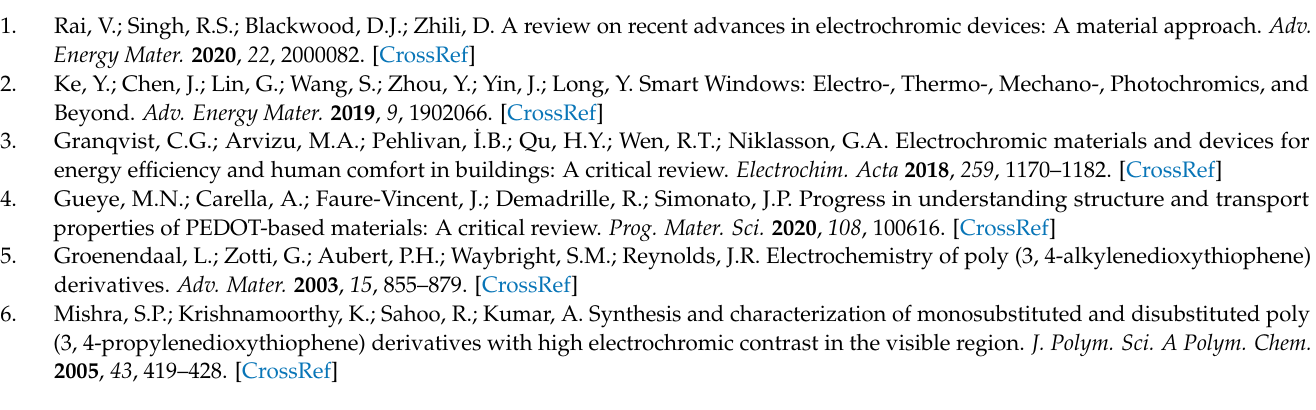
Q d .; Figure S2: i-t curves of the successive chronoamperometry experiments of the mPEDOT thin films electrodeposited using different Q d